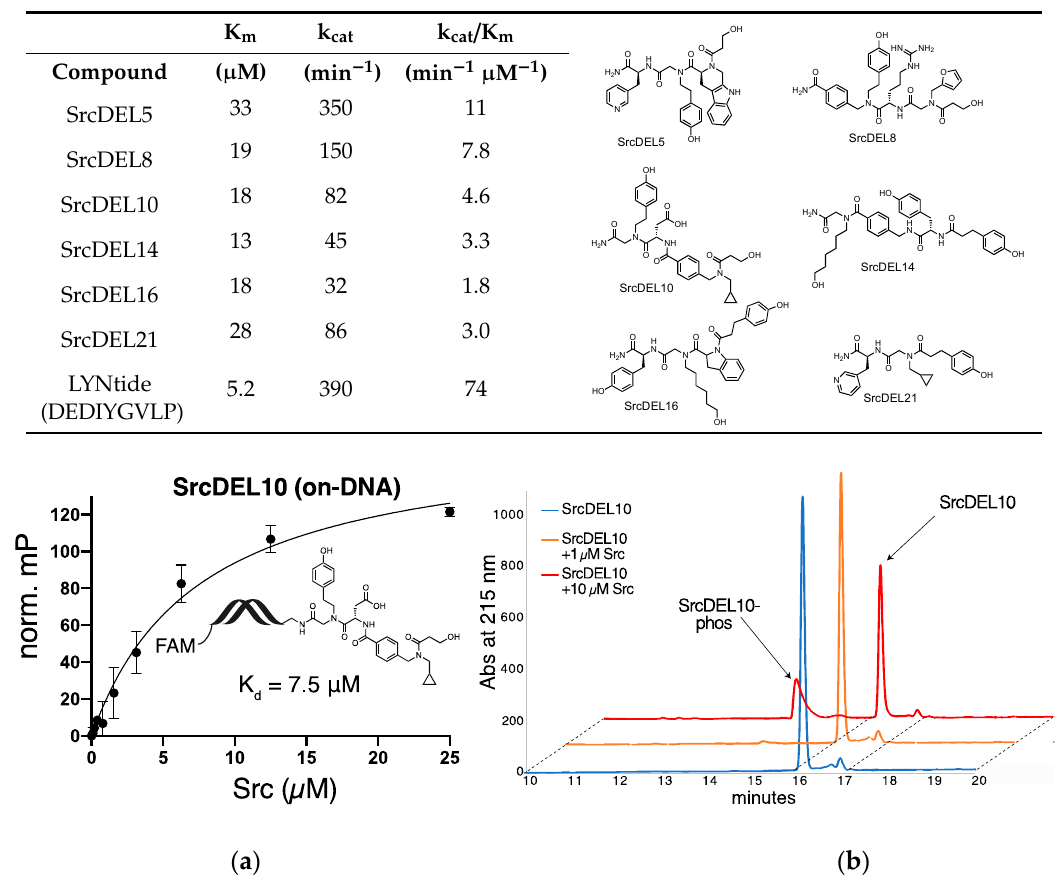
Table 1. Observed values for compounds in ADP-Glo assay. Table 1 . Observed values for compounds in ADP-Glo assay.